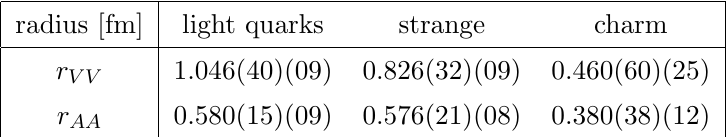
Table 5. Rms radii r for the correlator C 1 ( y ). The (cid:12)rst error is statistical and the second one due to the (cid:12)tting procedure, as speci(cid:12)ed in the